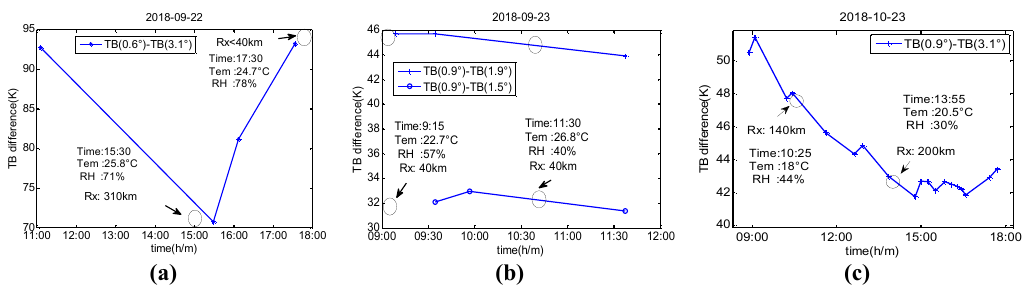
Figure 5. Observed LEATB difference and over-the-horizon detection capability (OTHDC). (a) , (b), and (c) on 22 September 2018, 23 September 2018, and 23 October 2018, respectively. The LEATB difference was obtained by the difference between the LEATB data at two elevation angles. For example, the LEATB difference between 𝑇𝐵(0.6 ∘ ) and 𝑇𝐵(3.1 ∘ ) in (a) represents the difference between the LEATB values at elevation angle 0.6° and 3.1°. The 𝑅𝑚𝑎𝑥 is the maximum range of radar echoes. The ’Time’, ‘Tem’, and ‘RH’ represent local standard time (Beijing time), temperature, and relative humidity, respectively.